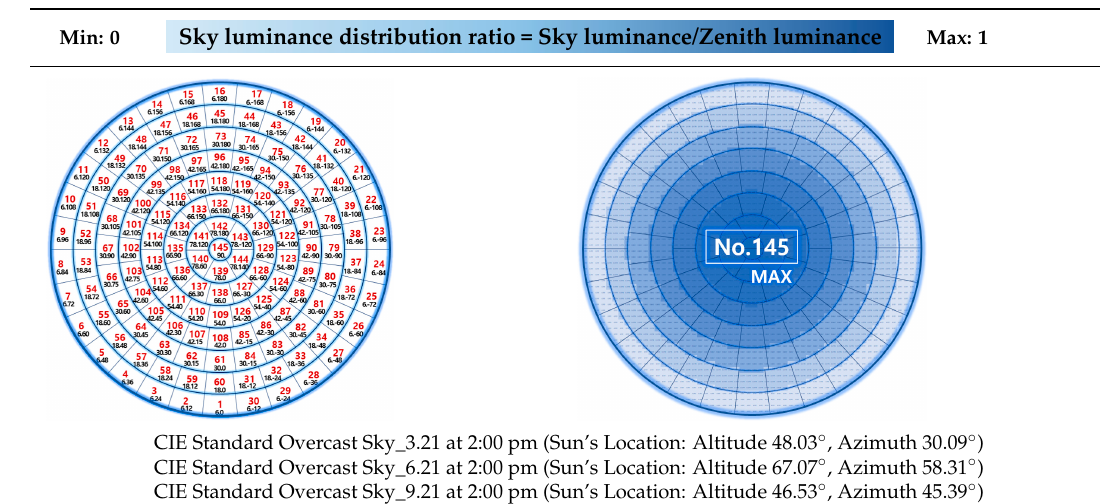
Table 7. Sky luminance distribution of CIE standard overcast sky.